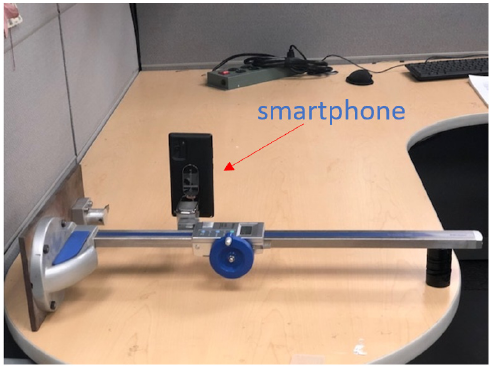
Figure 12. Linear rail set up for inducing translational camera